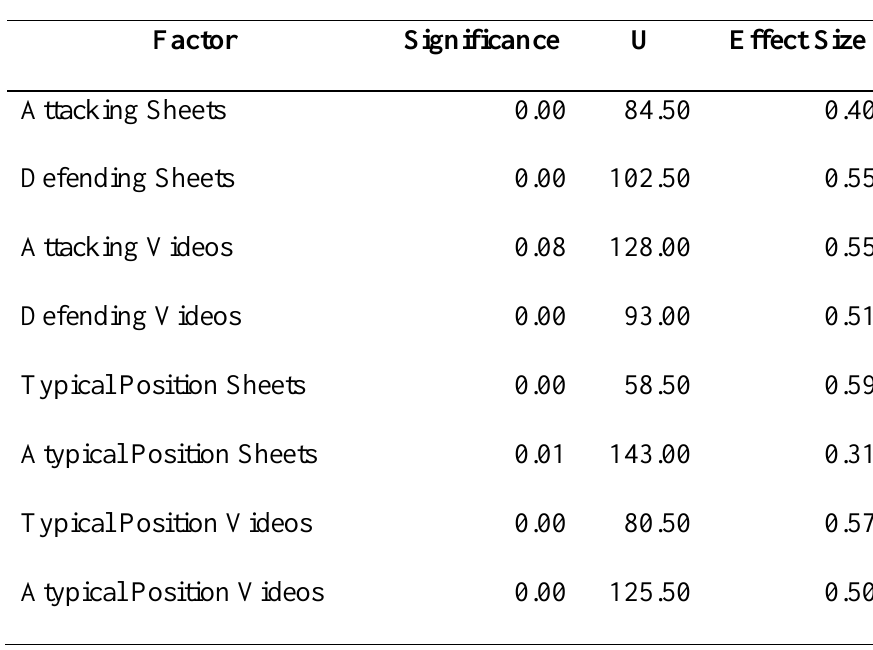
Table 4.3 – Comparisons of Actual to Random